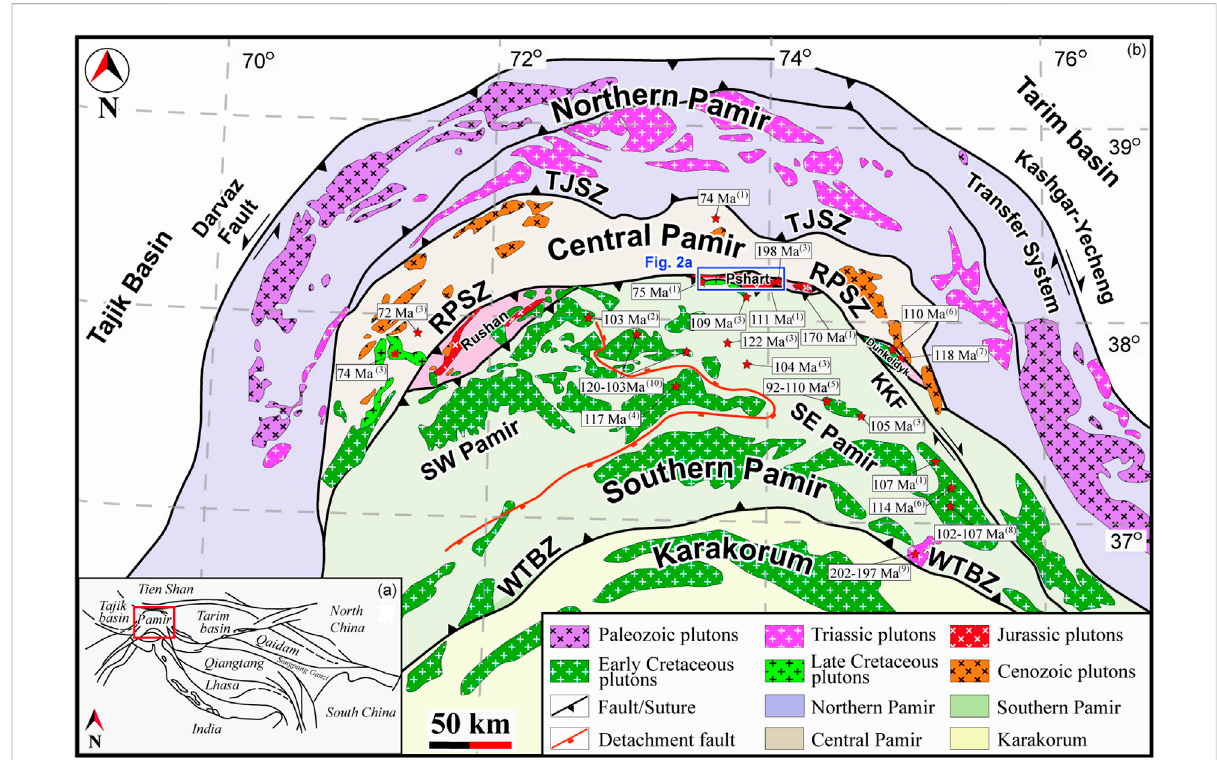
FIGURE 1 (A) TectonicschemeofCentralAsiaandTibetareashowingthemainsutures andregionalscale. (B) GeologicmapofthePamirMountains,with the distributions of igneous rocks of different ages shown in different colors. TJSZ, Tanymas – Jingsha Suture Zone; RPSZ, Rushan – Pshart Suture Zone;WTSZ,Wakhan – TirichBoundary Zone;KKF, Karakoramfault.The agesandlocations oftheJurassic – Cretaceousigneous rockswereadopted from(1)Schwabetal.(2004);(2)Stearnsetal.(2015);(3)Chapmanetal.(2018b);(4)Zanchettaetal.(2018);(5)Aminovetal.(2017);(6)Jiangetal. (2014);(7)(LiR.H.etal.,2019)(8)Liuetal.(2020b);(9)(Liuetal.,2020c);(10)Worthingtonetal.(2020).Modi fi edfromAngiolinietal.(2015),Robinson (2015), and Zanchetta et al.